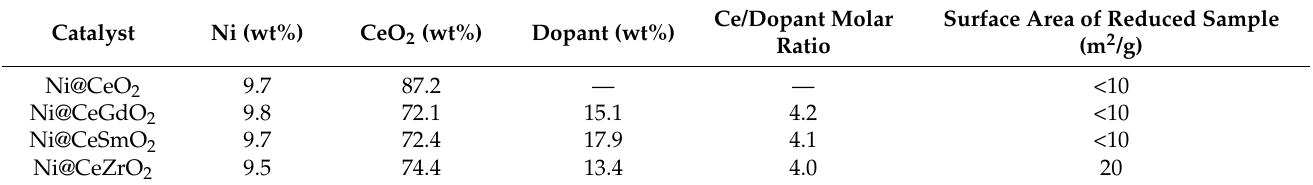
Table 1. Chemical composition and surface area after reduction at 800 ◦ C of the